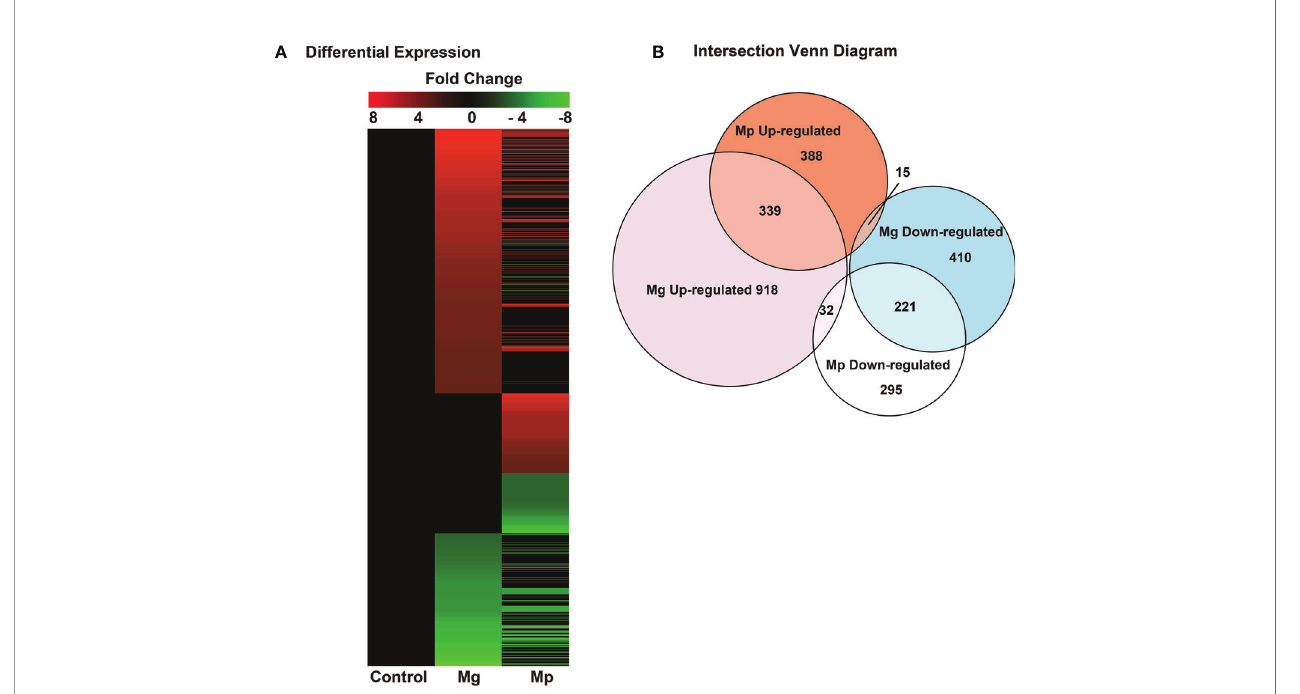
FIGURE 1 | Pro fi le of RNA-seq based differentially expressed genes in M. genitalium (Mg) and M. pneumoniae (Mp). (A) Heat map from the entire differentially expressed genes dataset. Only differentially expressed genes with 1.5-fold change were considered for subsequent analyses. (B) Intersection Venn diagram of differentially expressed genes in Mg and Mp